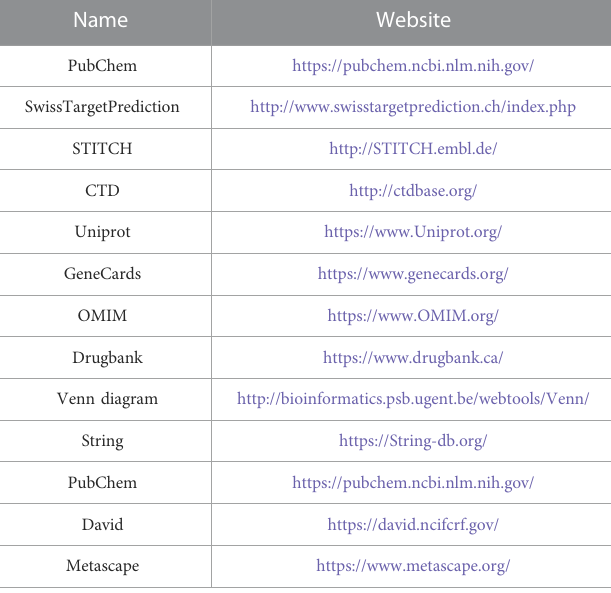
TABLE 1 Software and database for network